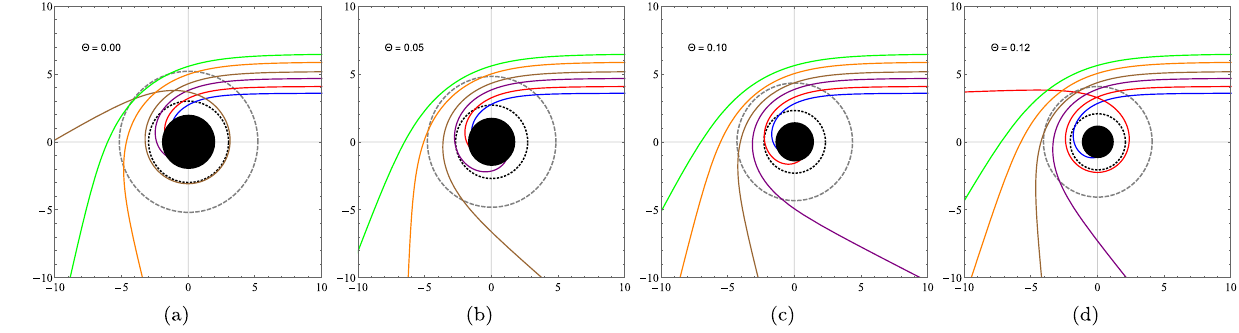
Figure 5. Geodesics surrounding a noncommutative black hole. The impact parameters defined as 3.6, 4.1, 4.7, 5.2, 5.9 and 6.5 are the same for all graphs, assuming M b = the noncommutative parameter on the geodesic curves from ( a ) (cid:31)